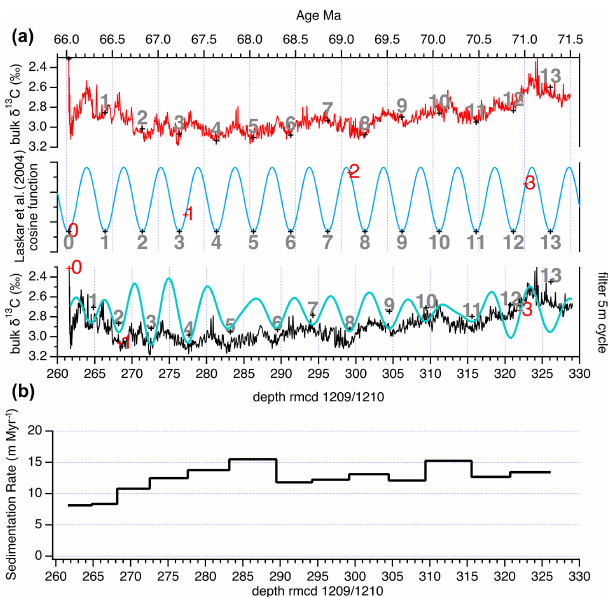
Figure 3. (a) Basic 405kyr age model was first made by assigning Shatsky Rise Sites 1209 and 1210 composite bulk δ 13 C to known tie points (red numbers). Then, a 5m filter (bandpass 0 . 2 ± 0 . 06) of bulk δ 13 C composite was modeled to know the cosine function (cyan line). This cosine function was correlated to the La2004 co- sine function (Laskar et al., 2004; blue line) minima for tuning the depth to the stable 405kyr cycle for an age. New age is tie points in Table S4. (b) Sedimentation rate in meters per million years (mMyr − 1 ) of composite depth (rmcd).